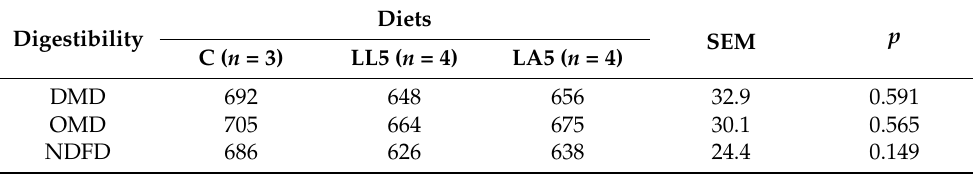
Table 6. Apparent digestibility coefficients (g/kg) of growing lambs in trial